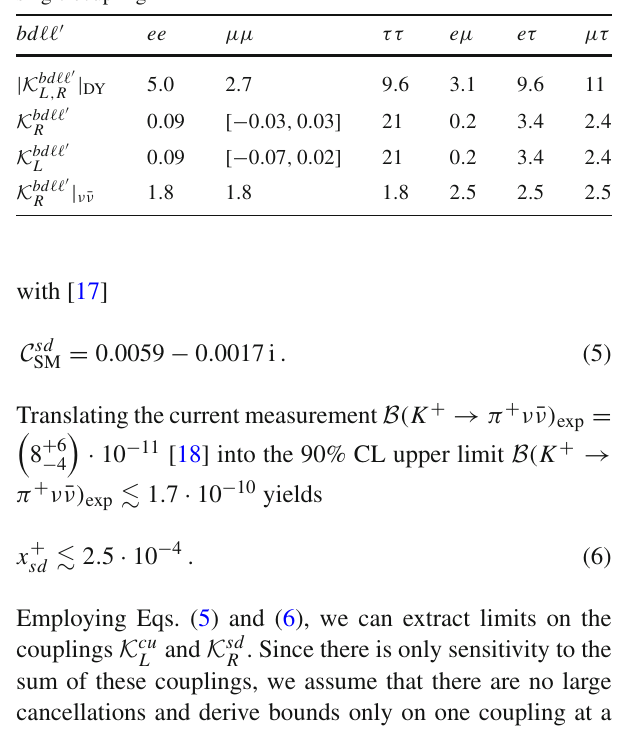
Table 5 Upper limits on charged dilepton couplings K bd (cid:4)(cid:4) (cid:2) p T [14,15] (top row), charged dilepton B -decays (middle rows) and derived ones from three-body rare B -decays to dineutrinos (bottom). Numbers without ranges correspond to a limit on the modulus. The μμ